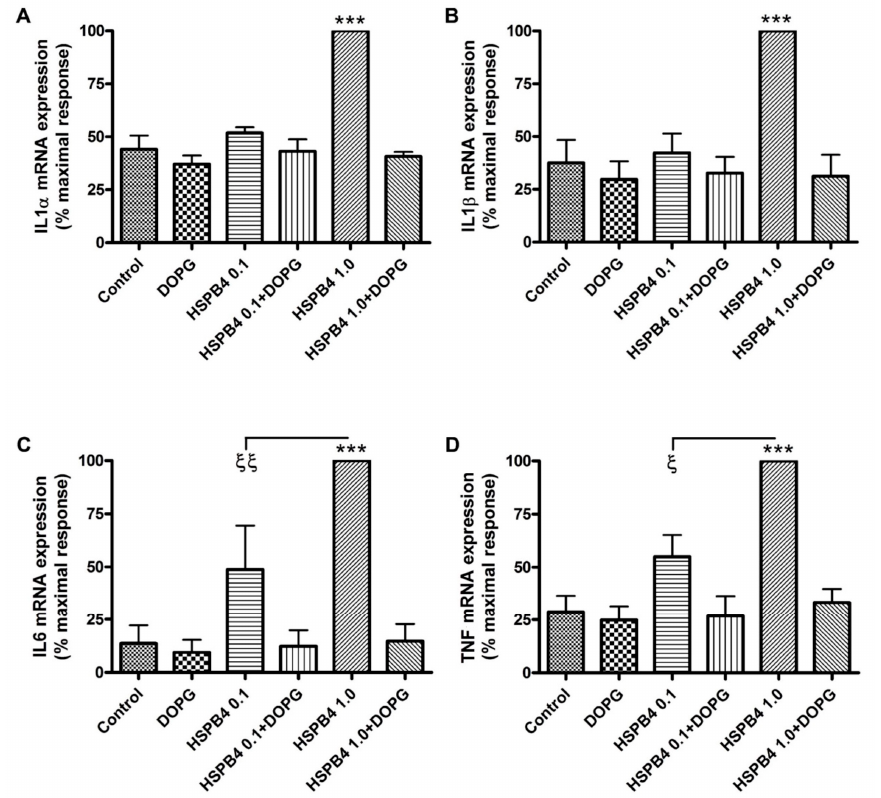
Figure 1. Upregulation of inflammatory mediator expression by recombinant HSPB4 is inhibited by DOPG in a macrophage cell line. RAW264.7 cells were treated with HSPB4 at 0, 0.1, or 1 µg/mL for